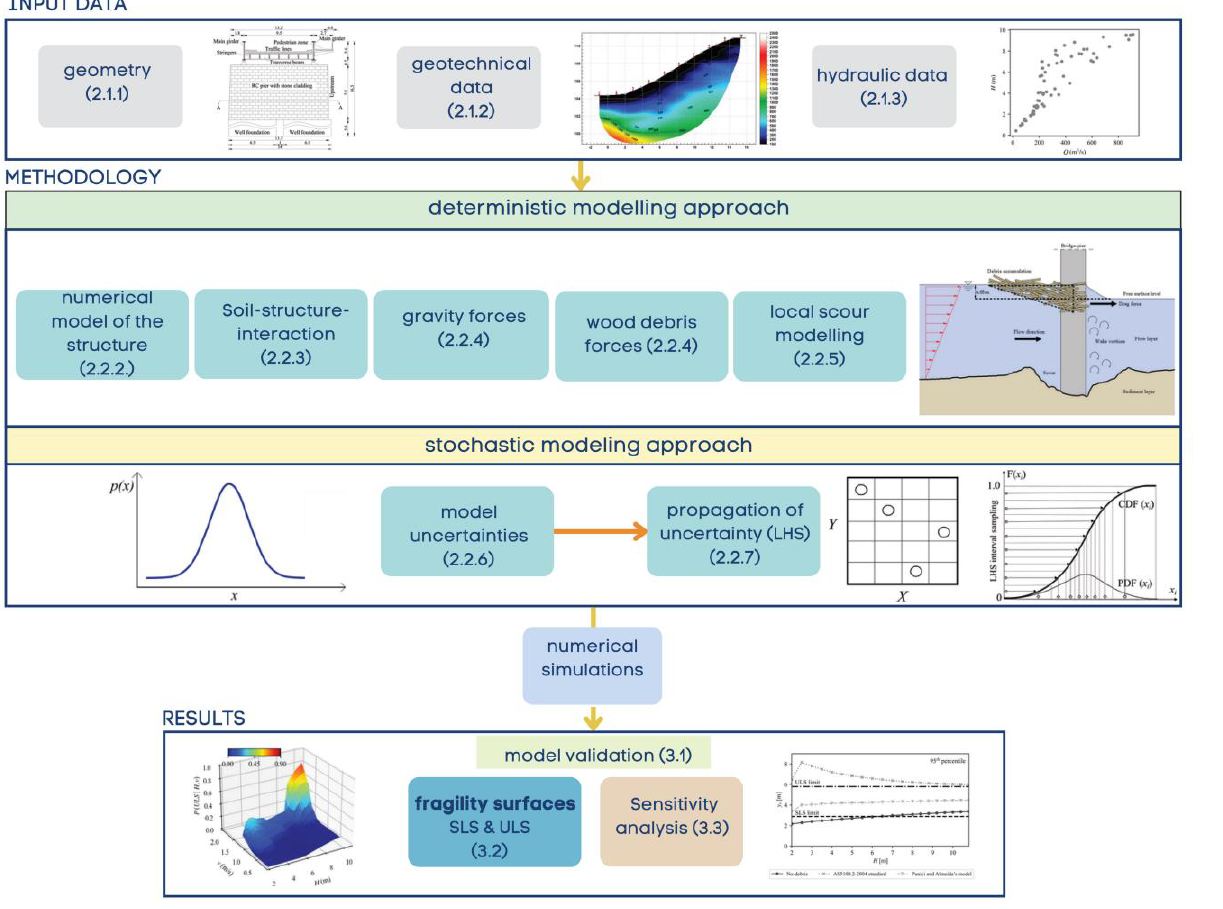
Figure 4. Flowchart illustrating the procedure that is implemented for the flood vulnerability analysis of the bridge.